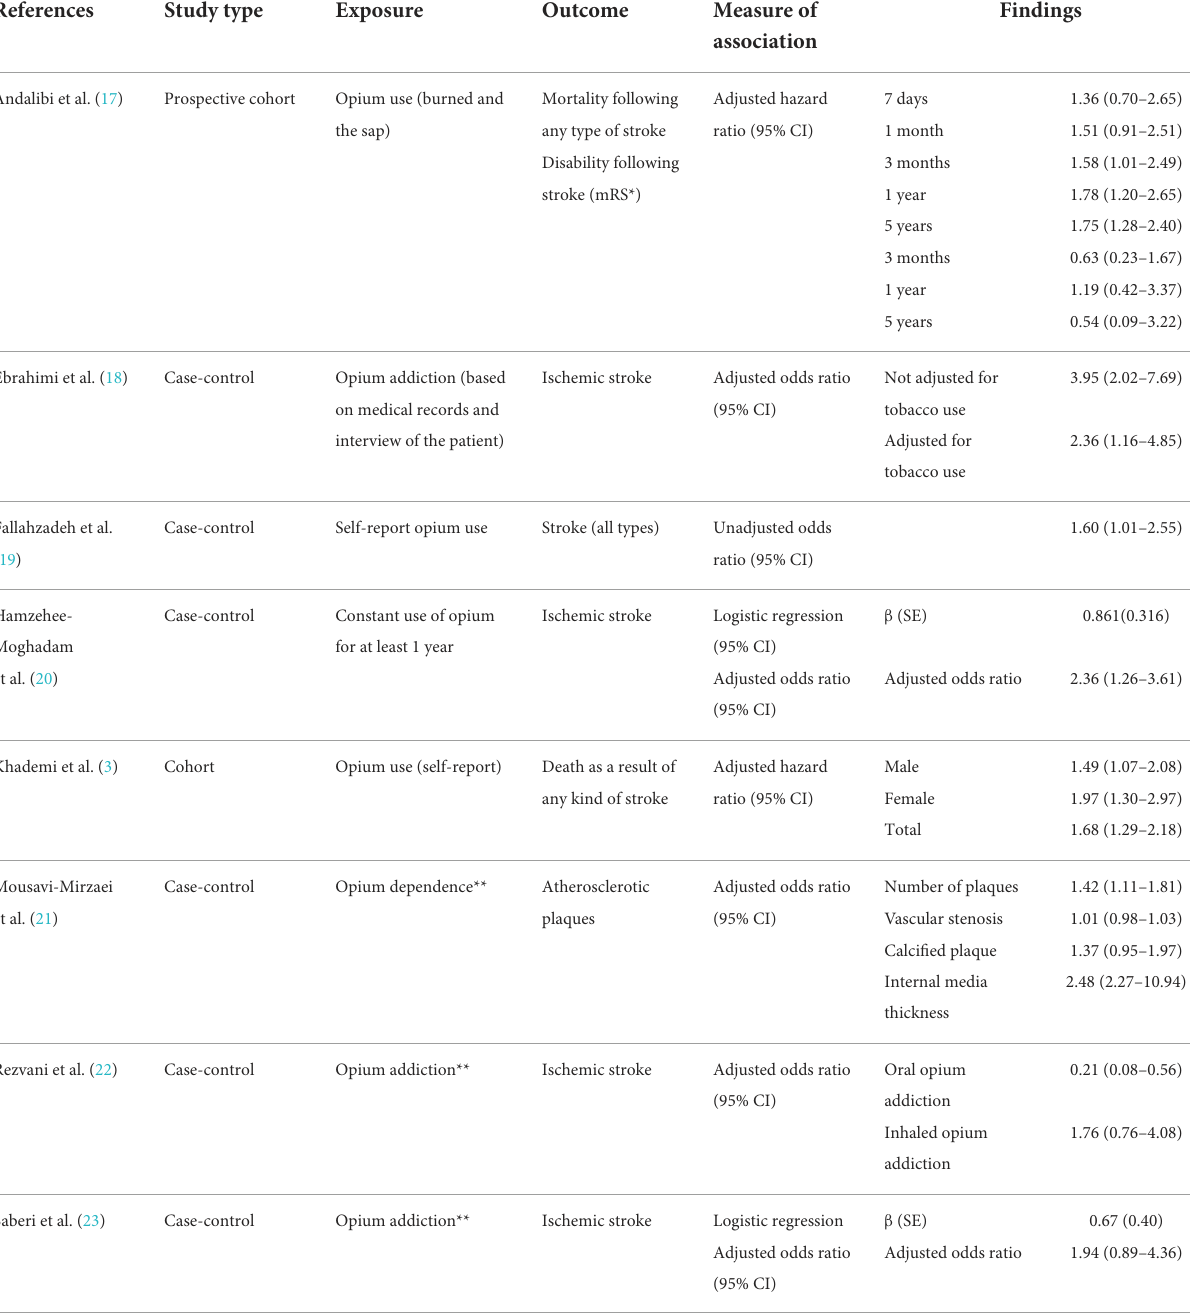
TABLE 2 Qualitative findings of included